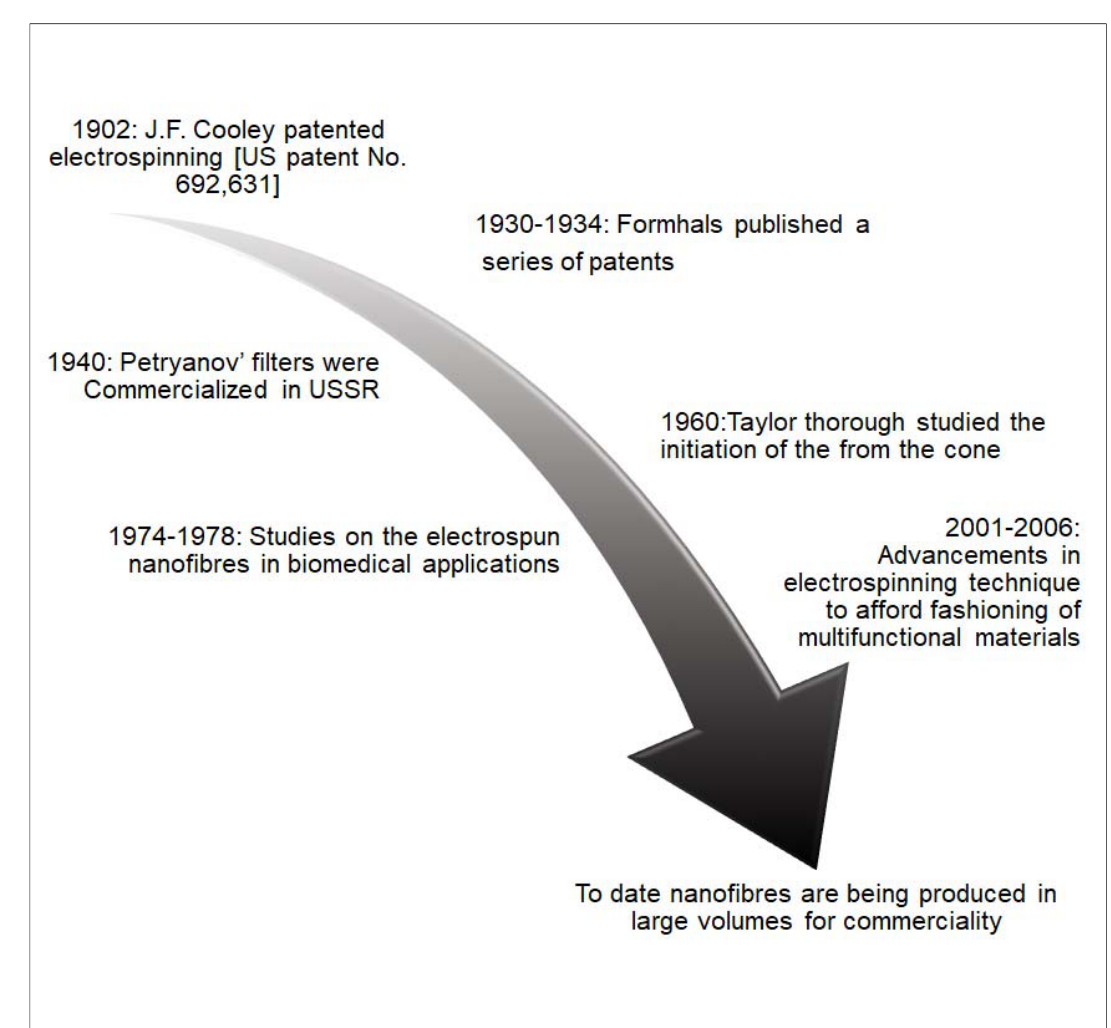
Figure 2. Brief history on the development of electrospinning.